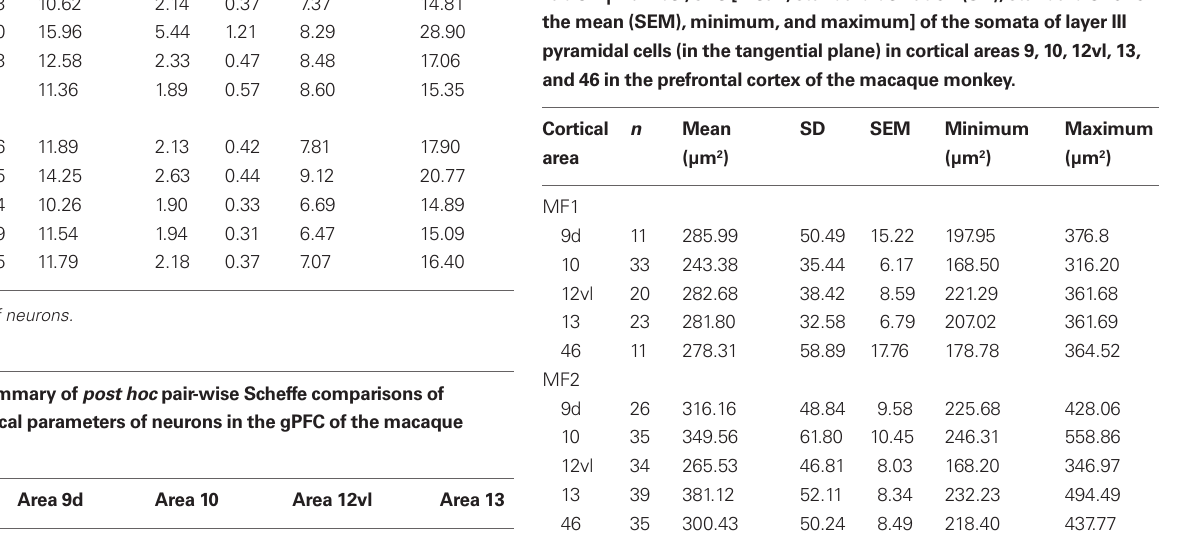
Table 4 | Number, size [mean, standard deviation (SD), standard error of the mean (SeM), minimum, and maximum] of the somata of layer iii